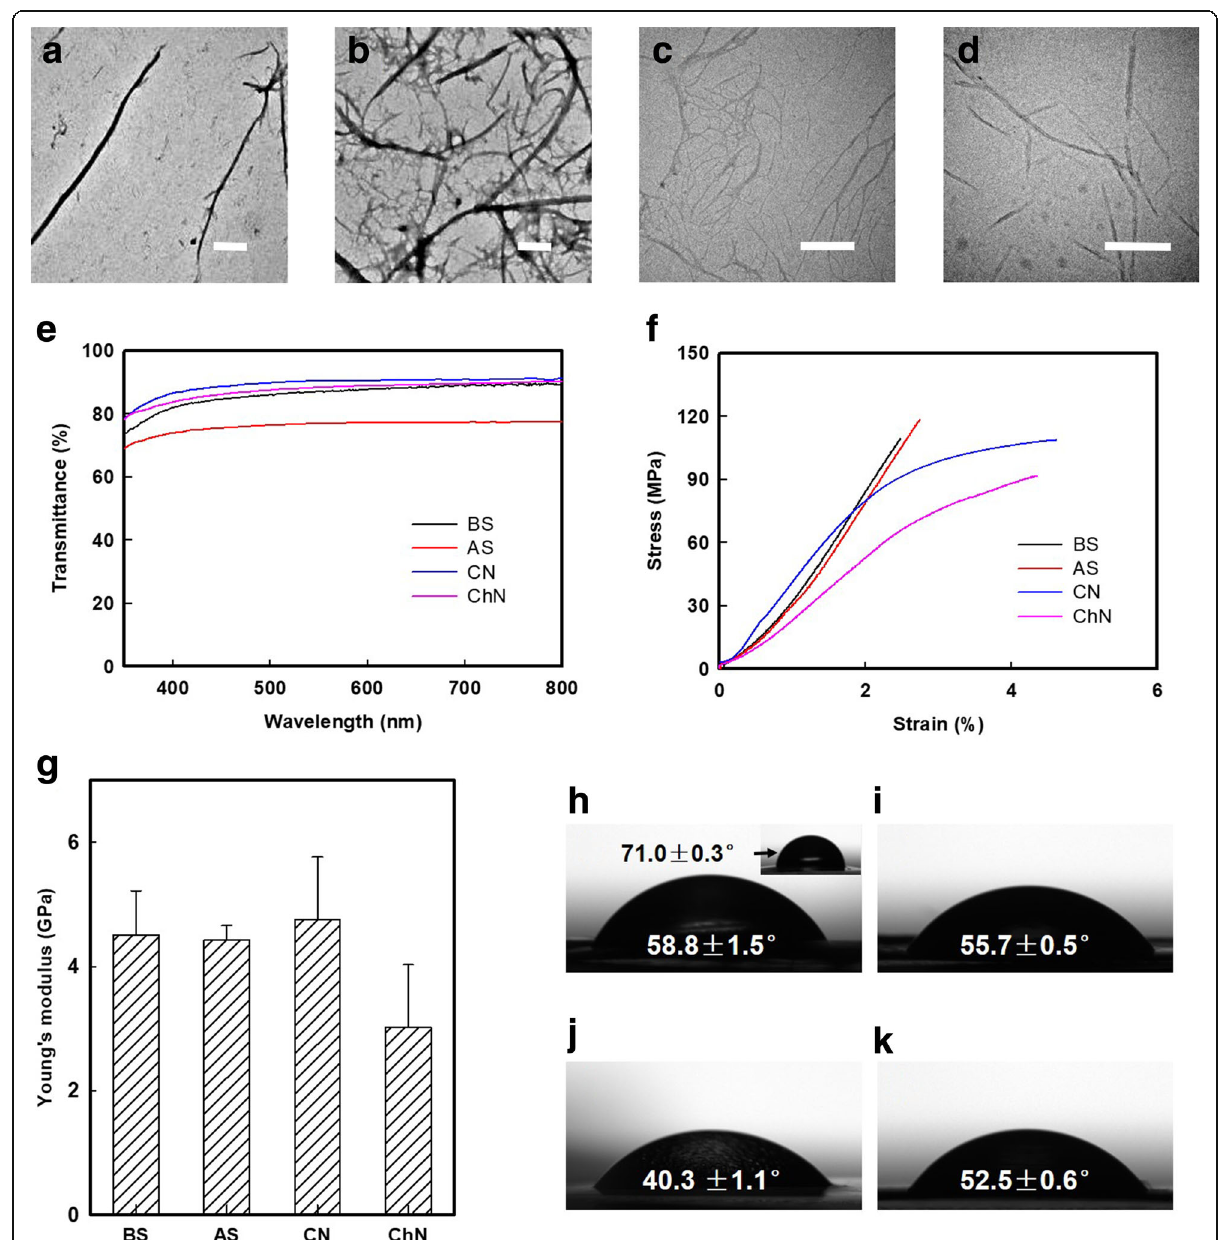
Fig. 4 Morphology and properties testing of SNs, CNs, and ChNs. Transmission electron microscopy (TEM) observation of resultant a BS and b AS nanofibers that oxidized by 10mM/g protein NaClO addition, c cellulose nanofibers (CNs), and d chitin nanofibers (ChNs) that achieved by TEMPO- mediated oxidation. The scale bar is 500nm. e UV-Vis transmittance of approximately 50- μ m-thick membranes that cast by BS, AS, cellulose (CN), and chitin (ChN) nanofibers. f Representative stress-strain curves of approximately 50- μ m-thick membranes that cast by BS, AS, CN, and ChN nanofibers. g Young ’ s modulus of membranes that are casting from BS, AS, CN, and ChN nanofibers. Data represent the mean SD ( n =5). h – k The water contact angle of membrane cast by f BS nanofibers was 58.8±1.5°, significantly reduced from that of regenerated BS membrane (71.0±0.3°, the inset image). 55.7±0.5, 40.3±1.1, and 52.5±0.6° of water contact angle was presented in AS, CN, and ChN membrane,